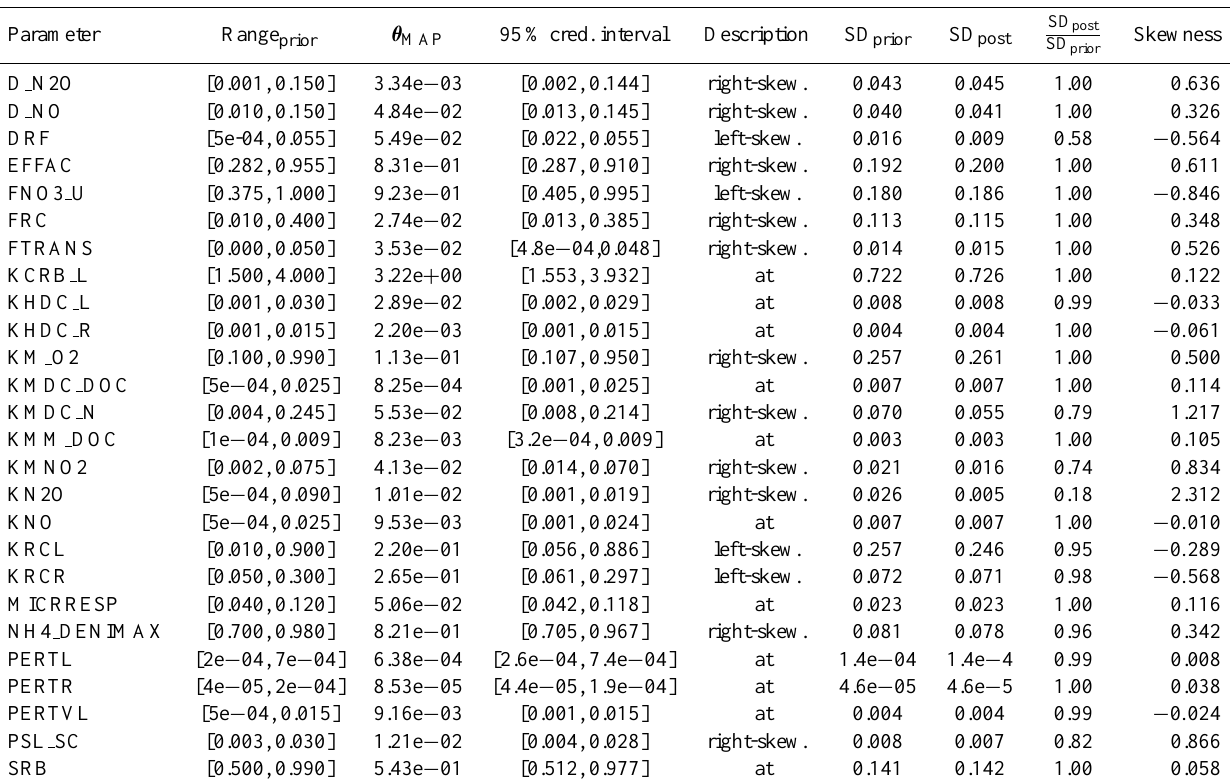
Table 2. Summary of marginal posterior parameter distribution and prior ranges (column 2). Posterior SD and skewness were estimated, whereas the prior SD was analytically